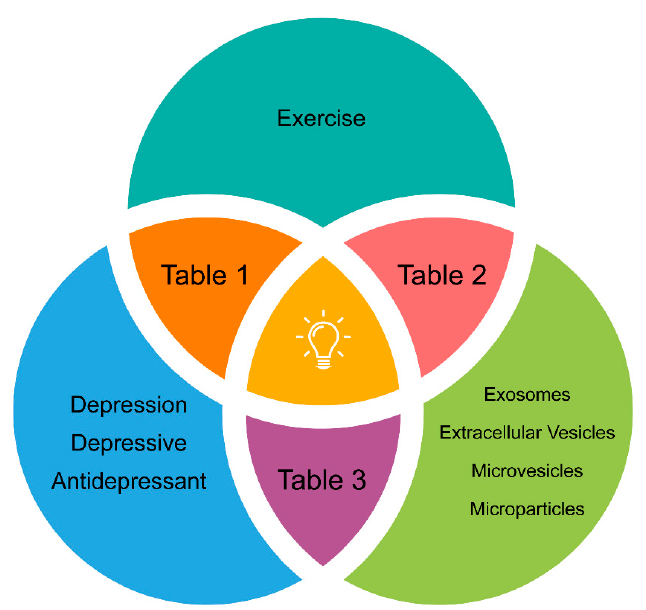
Figure 2. Keywords from the PubMed online database search. Results are shown for each combination of keyword search including clinical trials published over the last 5 years (2014–2019) according to the inclusion/exclusion criteria described in the manuscript. The results are summarized in Tables 1–3, as illustrated.